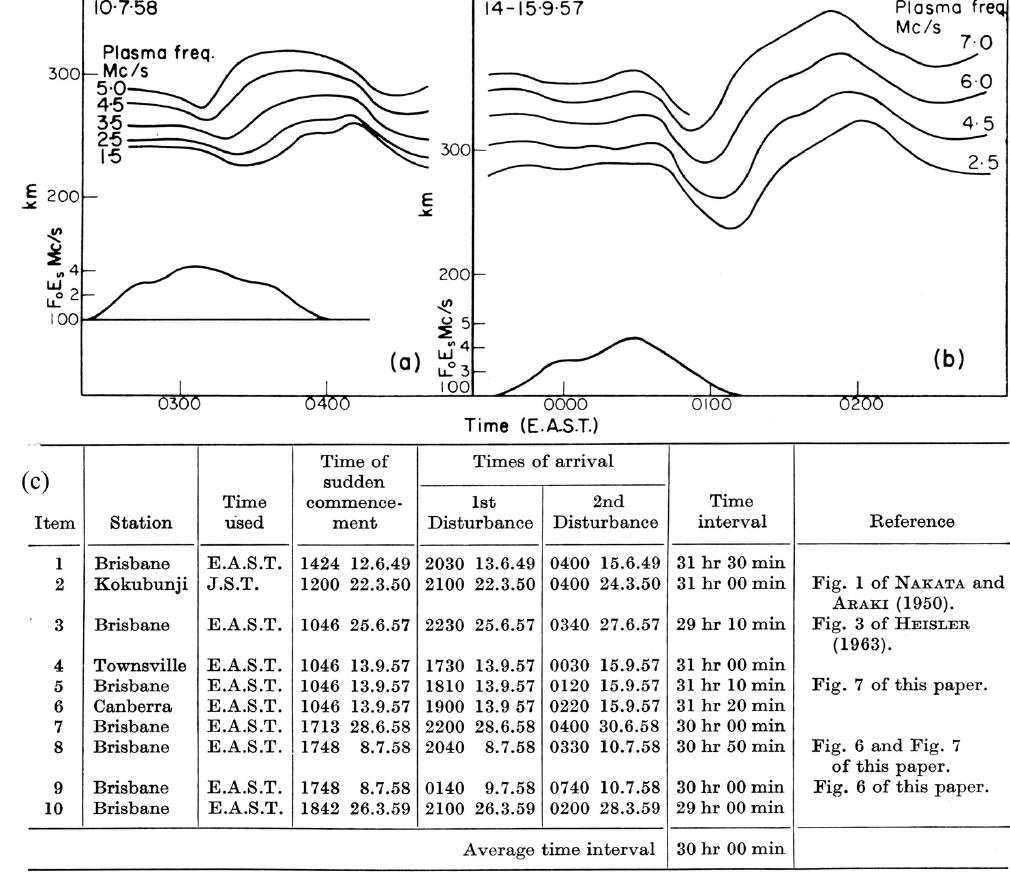
Fig. 5. A reproduction of (a) and (b) of Fig. 7 of Bowman (1965) involving LS- TID induced fo Es and other changes, (a) involves encir- clement of the earth. (c) a reproduction of Table 2 of Bowman (1965) involving 10 encirclements by